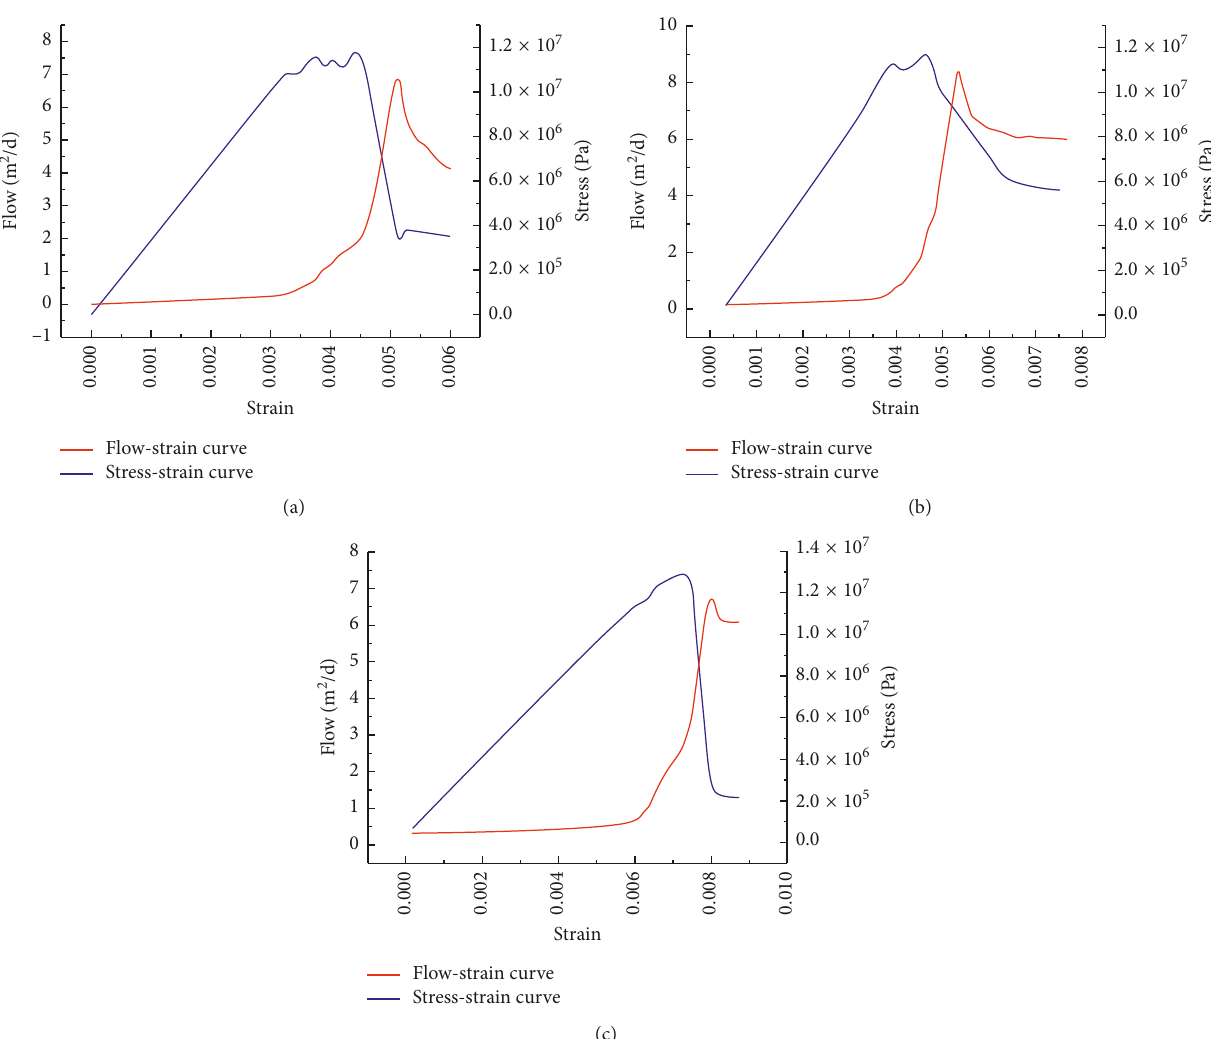
30 ° ; (b) β 45 ° ; (c) β 60 ° (cid:31) (cid:31) (cid:31)